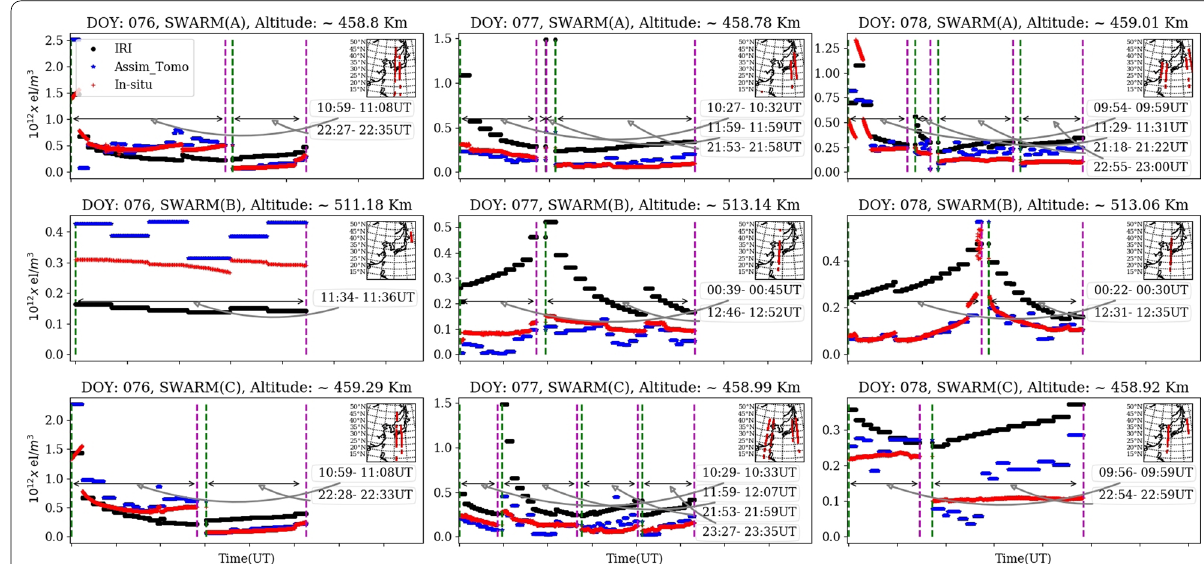
Fig. 5 A plot of time-density profiles following the Swarm satellites orbital paths, shown as red traces on the map in the upper right corner of each subplot. (Row subplots) Cover DOYs 076, 077, 078 in 2015. (Column subplots) Top, middle and bottom represent Swarm A, B and C, respectively. Black, blue and red represent IRI, reconstructed and Swarm in situ densities, respectively. In each subplot, vertical dashed lines show the start (green) and end (magenta) of grouped densities with time data gaps less than 1 h. Gray curved arrows match each grouped densities to the Swarm data time range, listed on the far right. The x-axis in each subplot is readjusted depending on the number of available grouped densities. Column-wise: top, middle and bottom panels correspond to Swarm Alpha (A), Charlie (C) and Bravo (B), respectively. Row-wise: right, middle and left subplots correspond to day of year 076, 077 and 078, respectively, when storm effects were